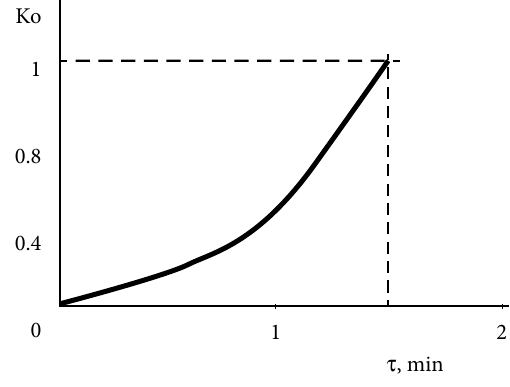
Fig. 1. Time to reach coefficient K 0 is 90 seconds.